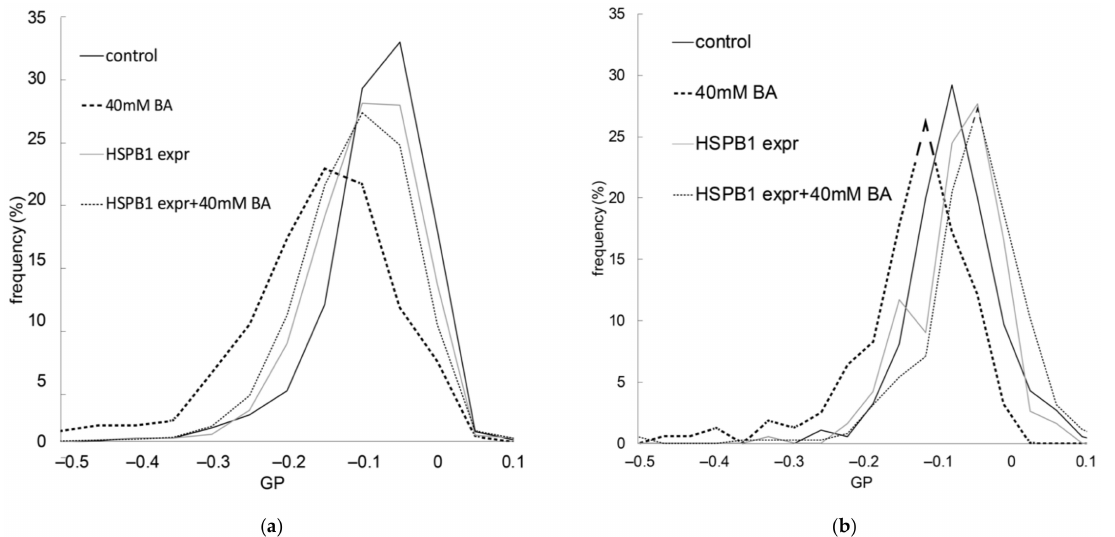
Figure 3. Effect of HSPB1 on the diffusion constant of STAR488-PEG-Chol fluorescent probe in supported bilayers. ITIR-FCS measurement was performed on a supported lipid bilayer made from ( a ) DOPC or ( b ) a 1:1:1 mixture of DOPC/SM/Chol before (first column) and after (second column) 15 min of 50 µ g HSPB1 administration. The third column gives diffusion constants of HSPB1-treated samples after incubation with 1 µ g/mL proteinase K for 15 min.